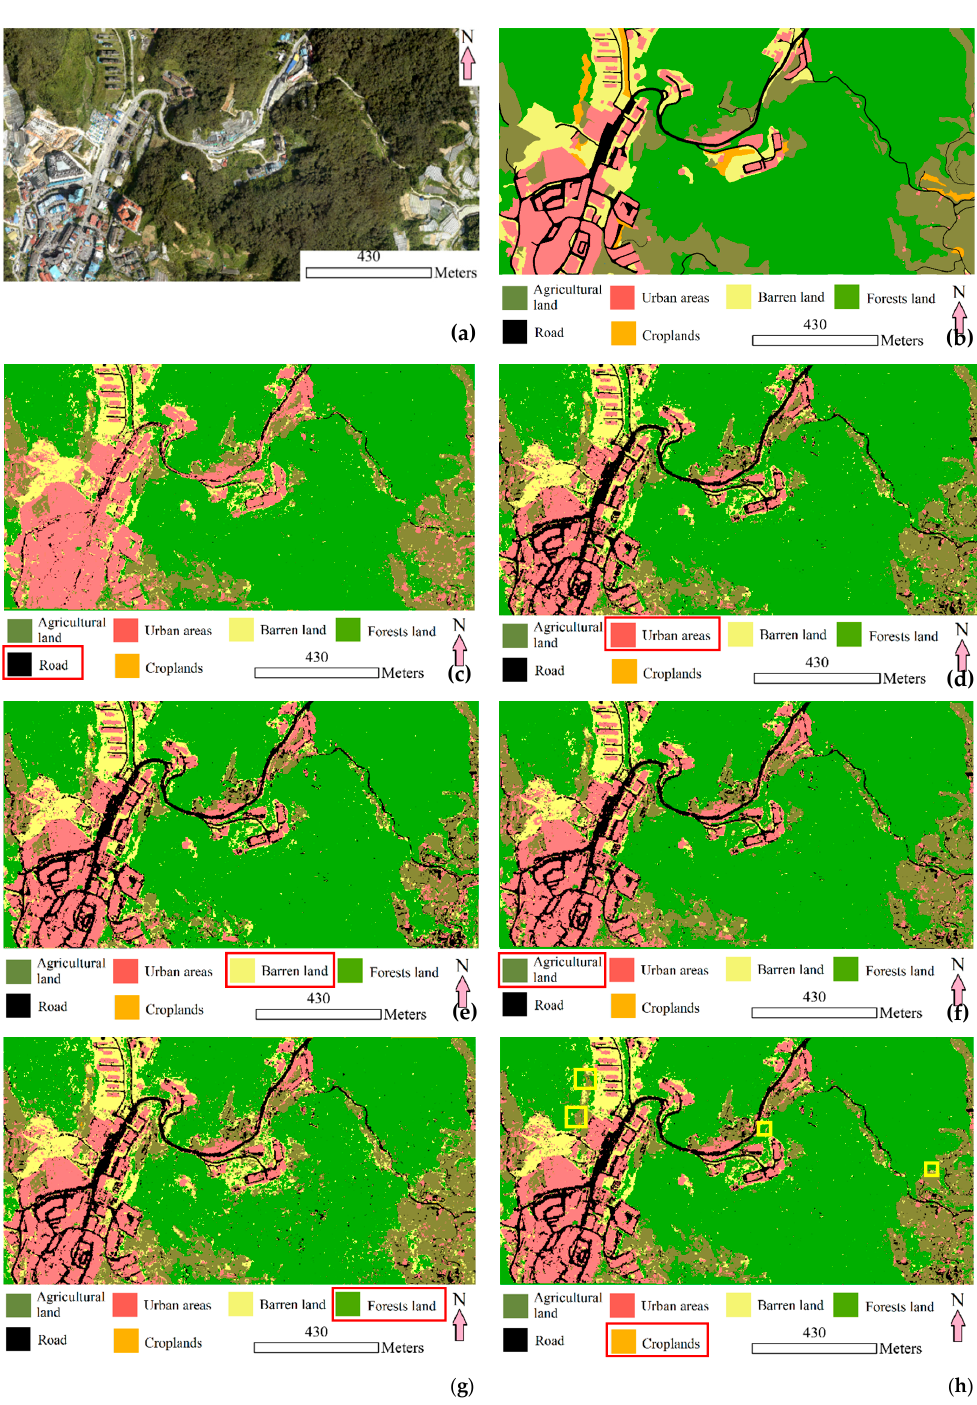
Figure 7. (a) Testing of the first dataset (Cameron Highlands area), (b) Ground truth map of testing Figure 7. ( a ) Testing of the first dataset (Cameron Highlands area), ( b ) Ground truth map of testing dataset, and classification results of the testing area with different unseen classes: (c) road, (d) urban dataset, and classification results of the testing area with di ff erent unseen classes: ( c ) road, ( d ) urban areas, (e) barren land, (f) agricultural land, (g) forest lands, and (h) croplands. areas, ( e ) barren land, ( f ) agricultural land, ( g ) forest lands, and ( h )